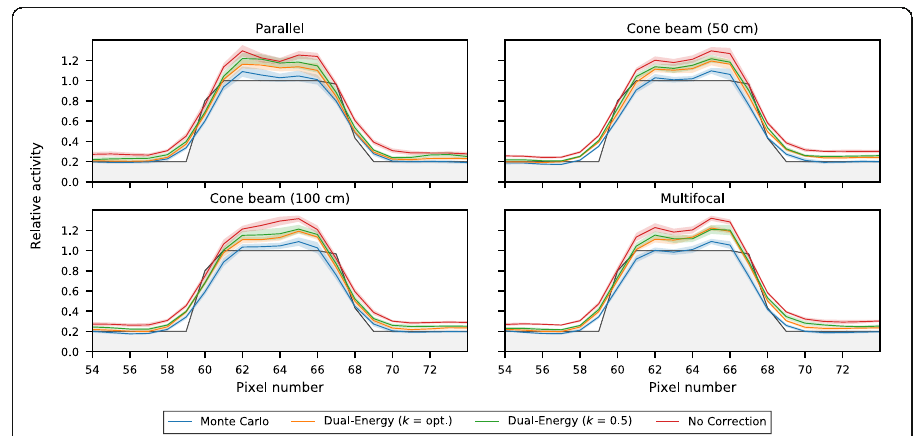
Fig. 10 Activity recovery profiles, normalized to the maximum activity, of the investigated scatter correction techniques for the several collimators. In black is the phantom